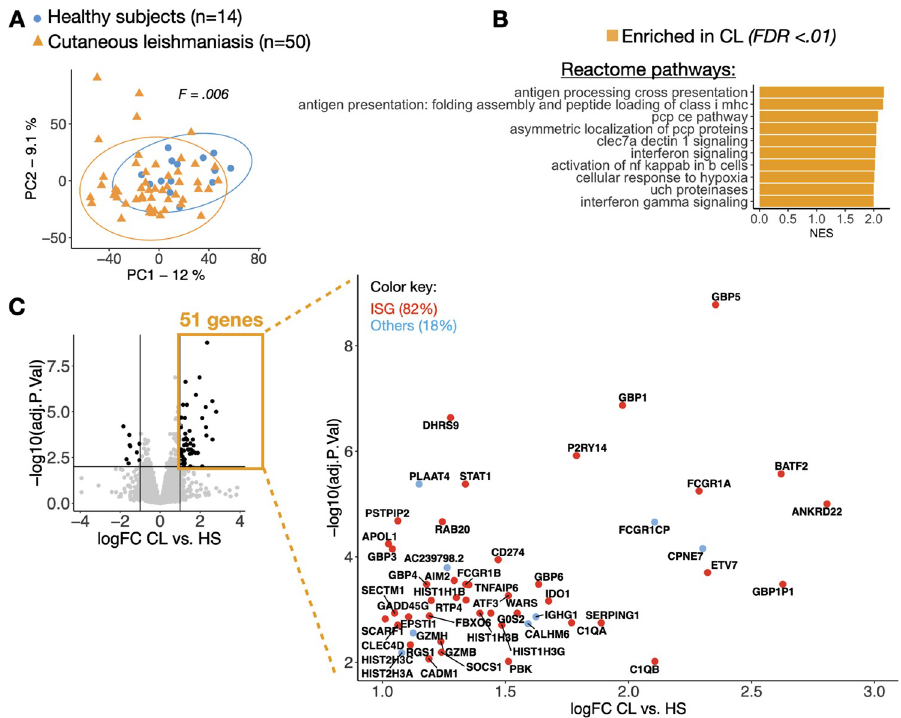
Fig 1. Transcriptional profiling identifies an Interferon-stimulated gene (ISG) signature in the peripheral blood of patients infected with Leishmania braziliensis . (A) Principal component analysis showing principal component 1 (PC1) and PC2 for RNA-seq data from the peripheral blood of CL patients (yellow triangles, n = 51) and HS (blue circles, n = 14). A PERMANOVA statistical test was used to calculate distances between the groups, Pr( > F) = .006. (B) Gene set enrichment analysis (GSEA) showing normalized enrichment scores (NES) of the top 10 pathways from the Reactome Pathway Database enriched in the peripheral blood of CL patients relative to HS. (C) Volcano plot highlighting overrepresented genes (n = 51) in the peripheral blood from CL patients relative to healthy subjects, FDR � 0.01 and logFC � 1. The Interferome database was used to identify Interferon-stimulated genes (ISGs), represented in red circles (n = 42, 82%). Other genes are colored in blue (n = 9, 18%).